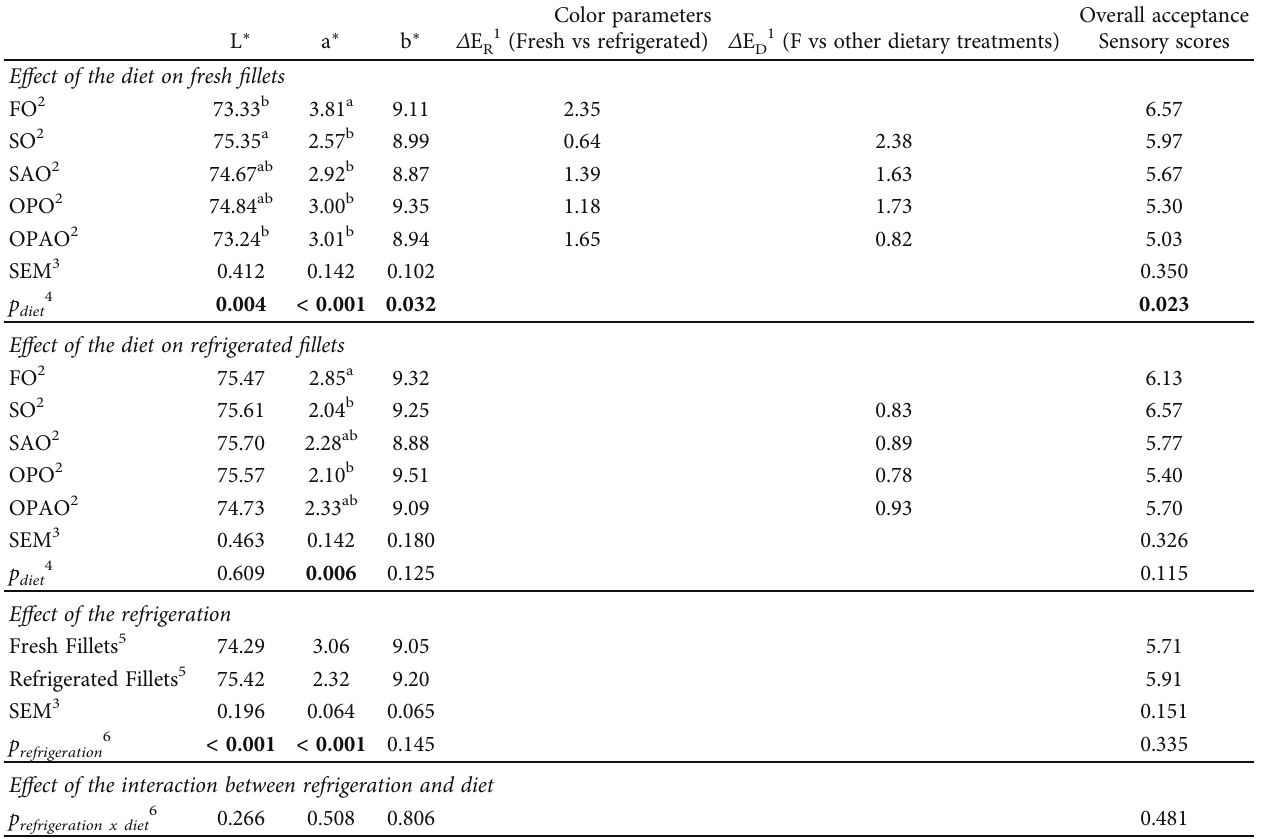
Abbreviations: For diet abbreviations (FO, SO, SAO, OPO and OPAO) see Table 2; L ∗ , Lightness; a ∗ , redness; b ∗ yellowness. 1 Δ E values were calculated